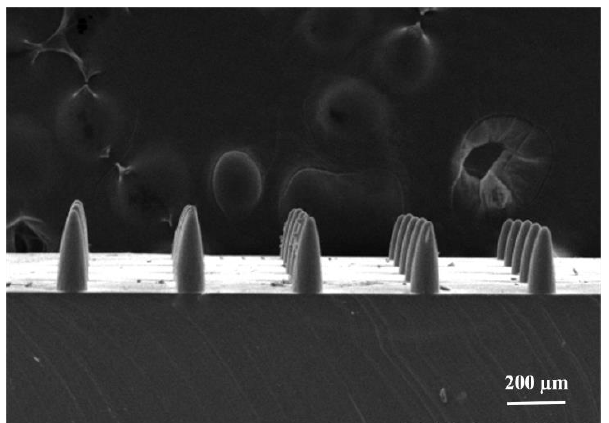
Figure 11. SEM image of conical MNA fabrication